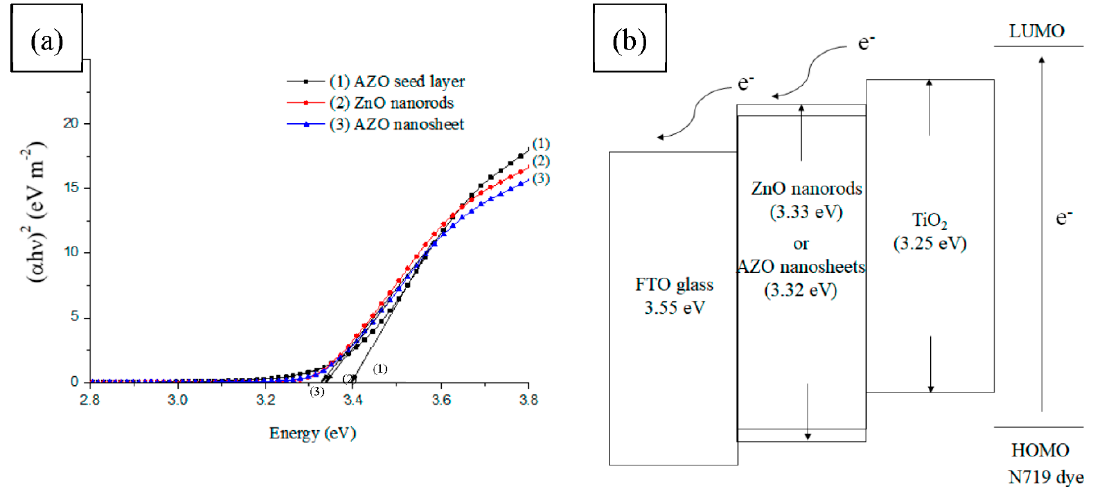
Figure 8. ( a ) The relationship between ( α h ν ) 2 and energy for the AZO seed layer, ZnO nanorods, and AZO nanosheets films, respectively. ( b ) The band gaps of ZnO nanorods/TiO 2 and AZO nanosheets/TiO 2 photoanodes for DSSCs.